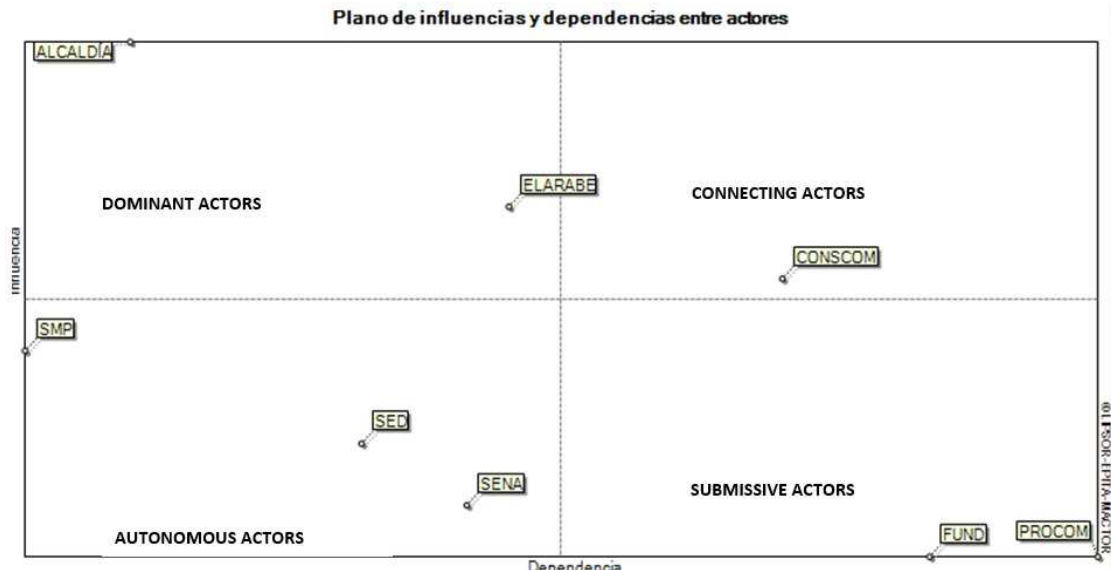
Figure 2. Matrix of indirect influence – actors